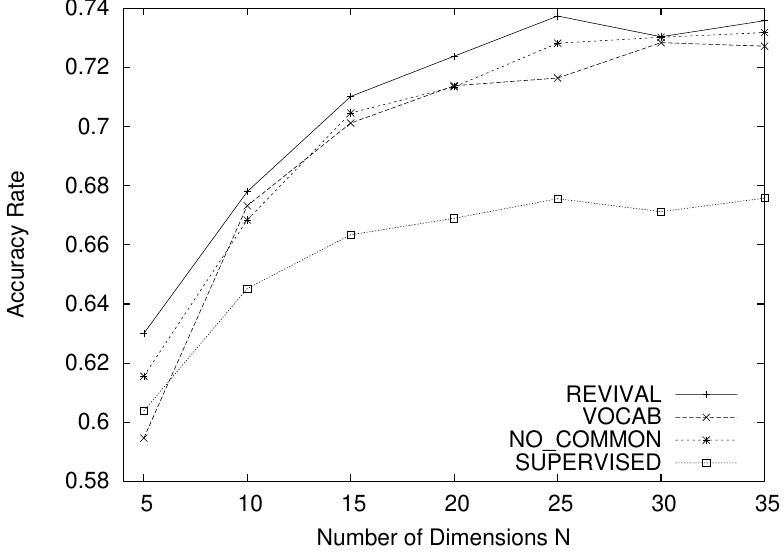
Figure 6. Accuracy rate for UC Merced land use dataset: